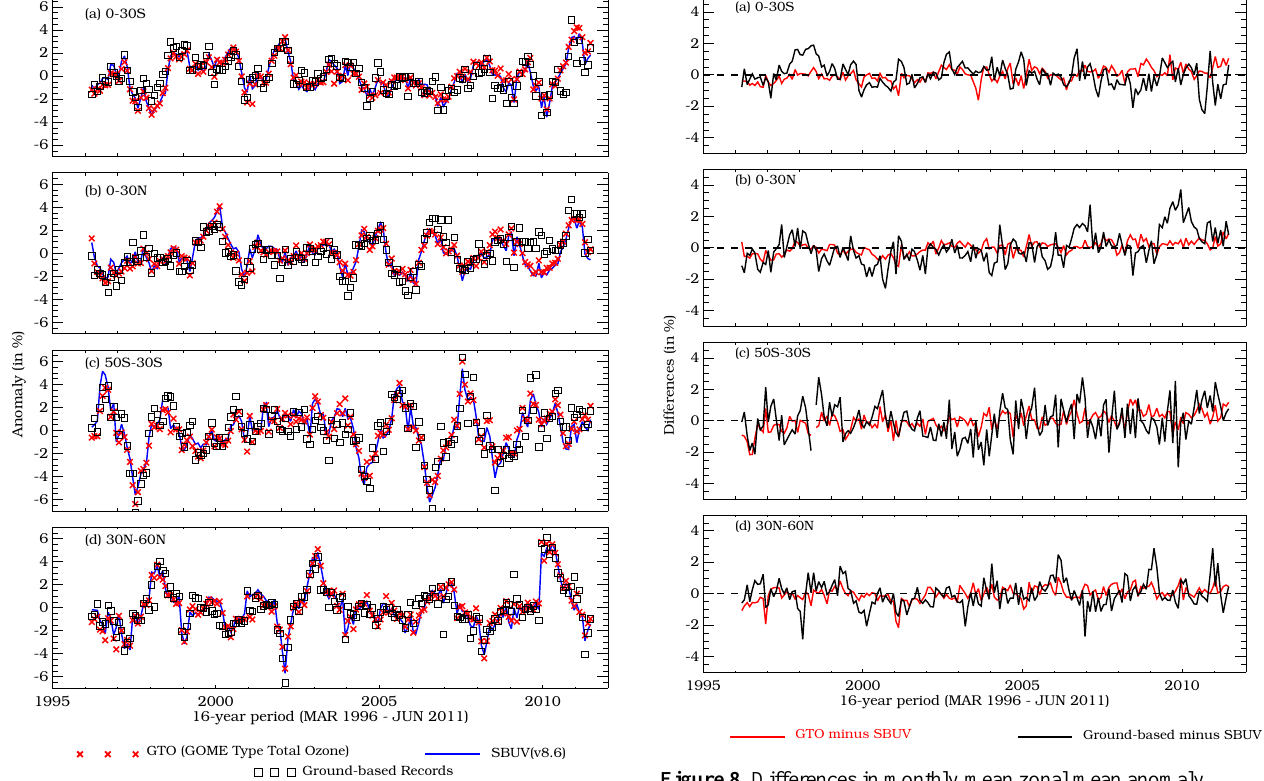
Figure 7. Monthly mean zonal mean anomaly.